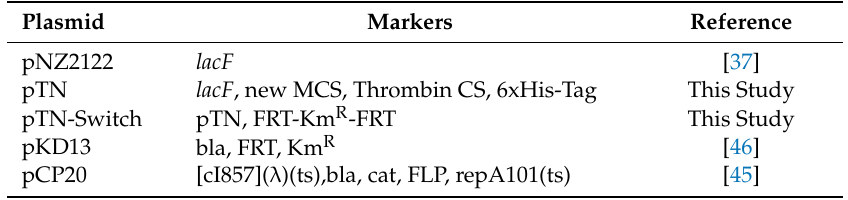
Table 2. The plasmids